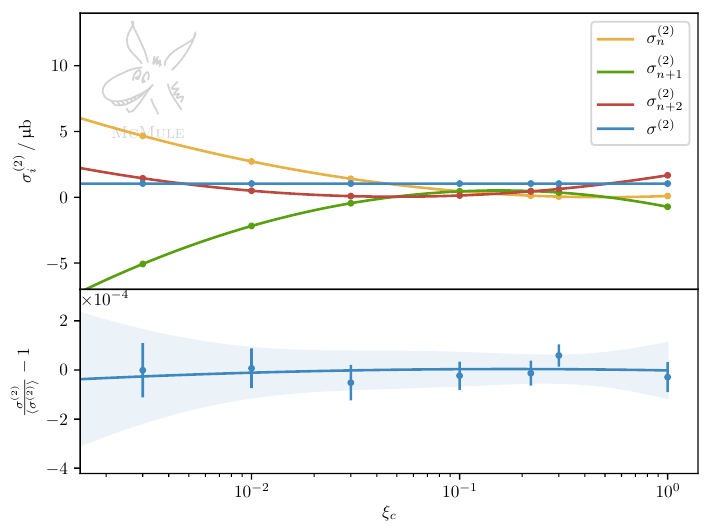
Figure 6: The (in)dependence of the pure NNLO contribution σ ( 2 ) to the total cross section on the arbitrary cut parameter ξ dence level of the